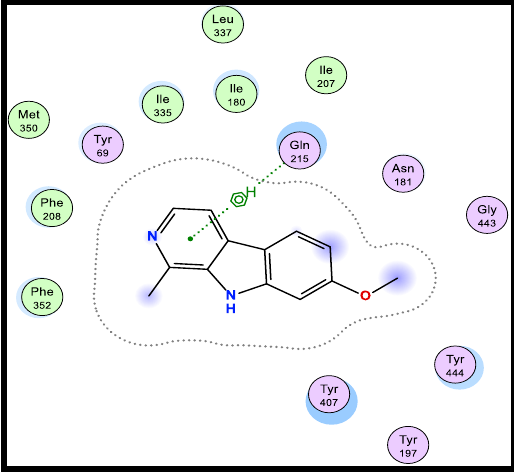
Figure 1. 2D-binding of HRM (a reference ligand) with